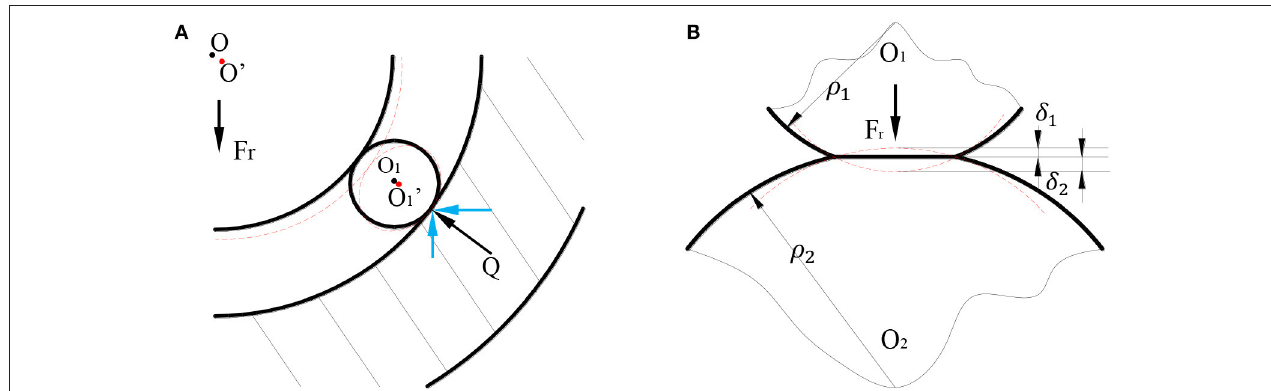
FIGURE 2 | Contact deformation. (A) Roller-raceway contact deformation. (B) Hertz contact